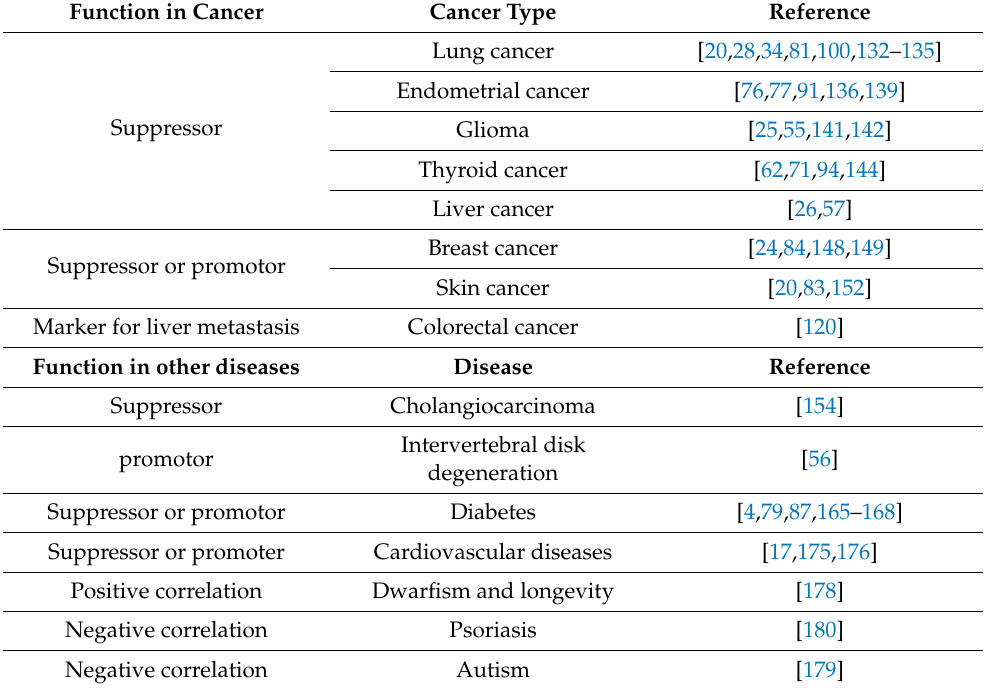
Table 1. Gene 33 and human